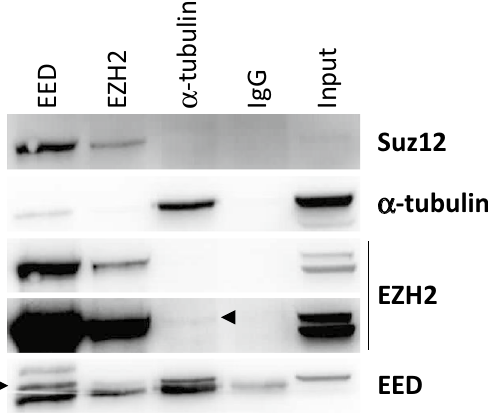
Figure 4. EED interacts with α-tubulin. Co-immunoprecipitation was performed using the SCIET27 cell line. EED, EZH2, α-tubulin or IgG used as negative control were immunoprecipitated and Suz12, EED, EZH2 and α-tubulin were detected by western blotting. For EZH2, two different expositions are shown to evidence low intensity bands. A representative western blot of the 3 performed is